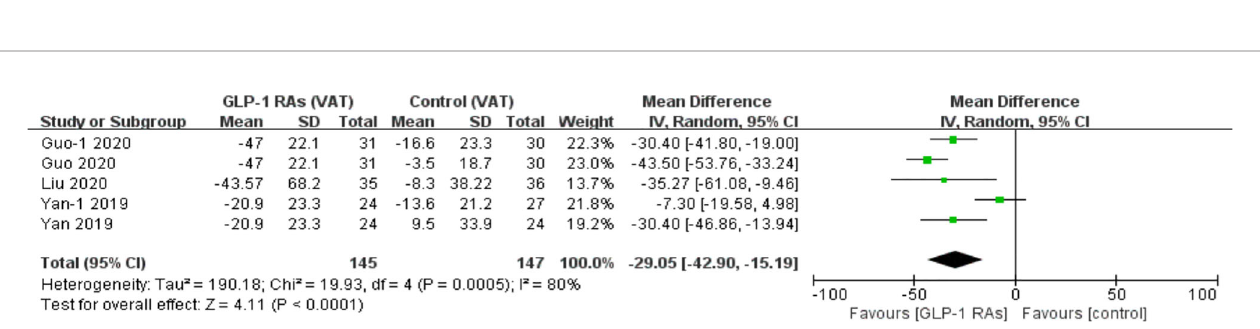
FIGURE 5 | Glucagon-like peptide-1 receptor agonists (GLP-lRAs); subcutaneous fat (SAT); SD, standard deviation; CI, con fi dence interval; IV, inverse variance; Guo-l, concluded liraglutide vs insulin; Yan-1, concluded liraglulide vs sitagliptin.